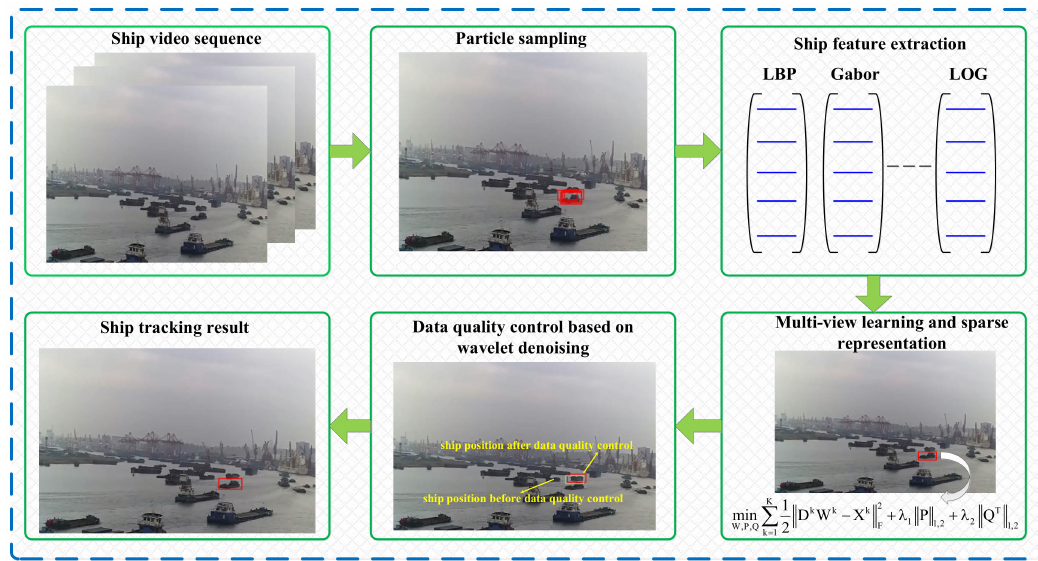
Figure 1. Schematic diagram of the proposed ship tracking framework. LOG = Laplacian of Gaussian. LBP = local binary